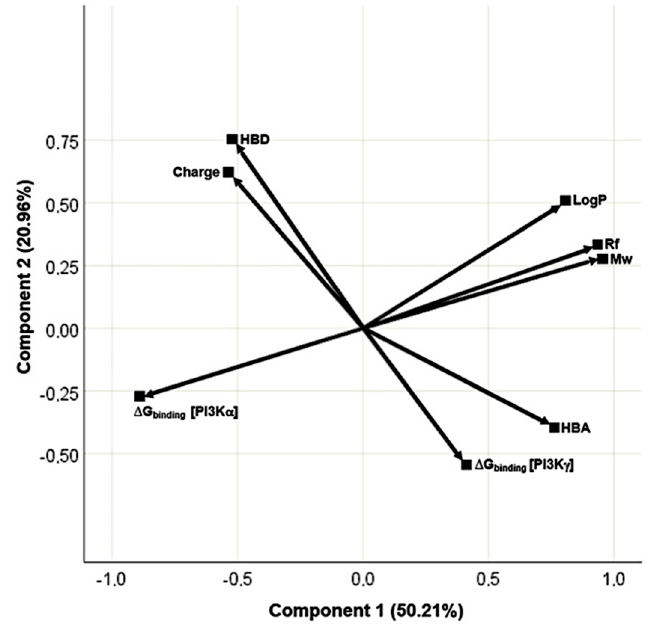
Figure 8. Principal component analysis (PCA) biplot of the first two components, objects factor scores, and loadings of data presented in Table 1. Rotated component matrix and scores were calculated using IBM SPSS Statistics software.